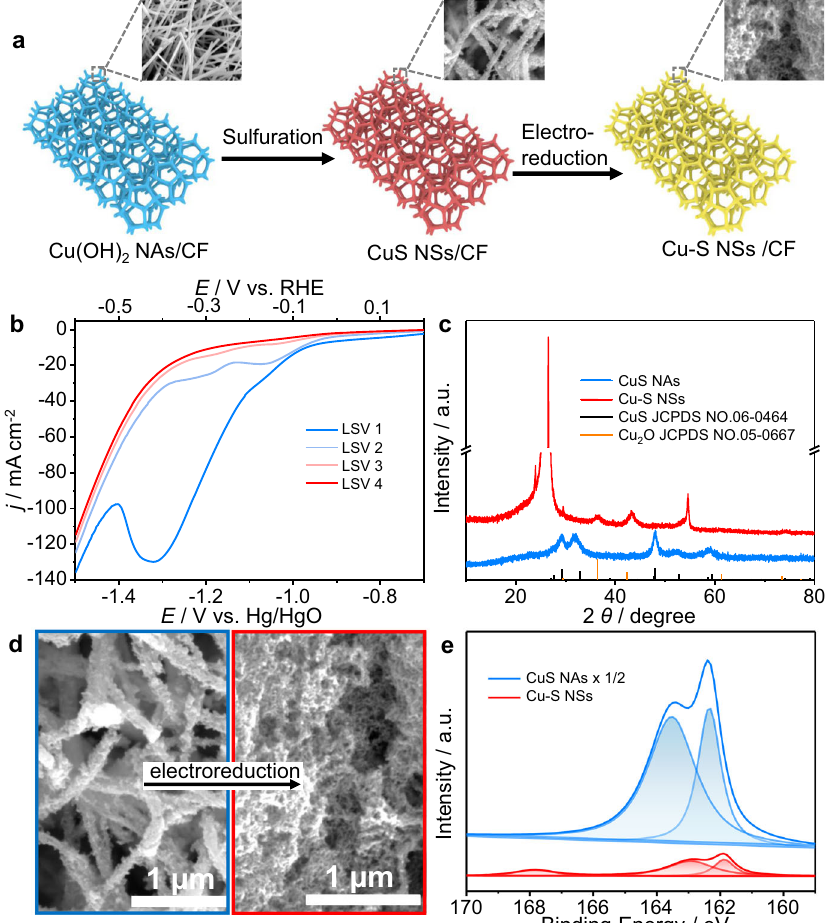
Fig. 2 Converting CuS NAs to Cu-S NSs under cathodic potential. a Scheme illustrating the in situ electroreductive conversion of CuS NAs precursors to Cu-S NSs. b LSV curves in the electroreduction process of CuS NAs. c XRD patterns, d SEM images, and e S 2 p spectra of CuS NAs and in situ-formed Cu-S